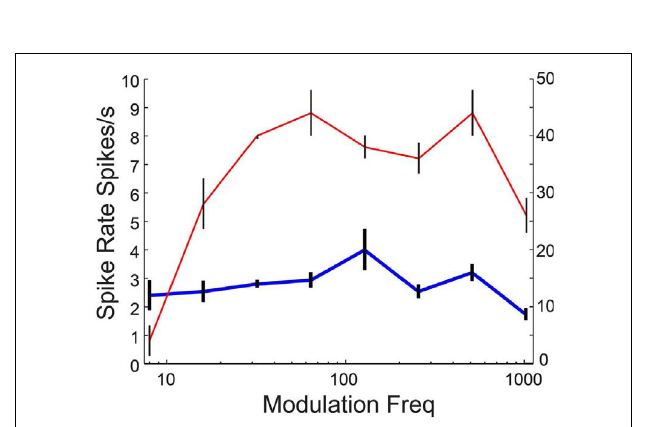
FIGUREA2 | Band-pass responses using excitatory inputs. Blue line shows rate responses taken from 750ms stimulation duration (Y-axis scale, left). Red line shows rate responses taken from first 50ms of stimulus onset (Y-axis scale, right).